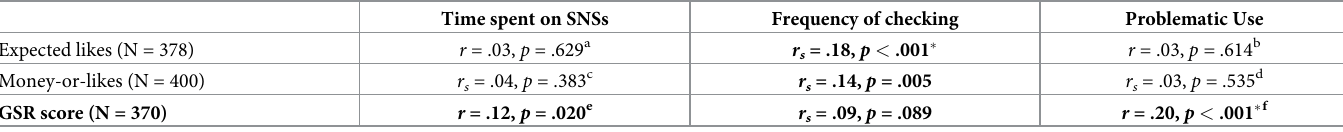
Table 3. Associations between secondary measures and the three usage